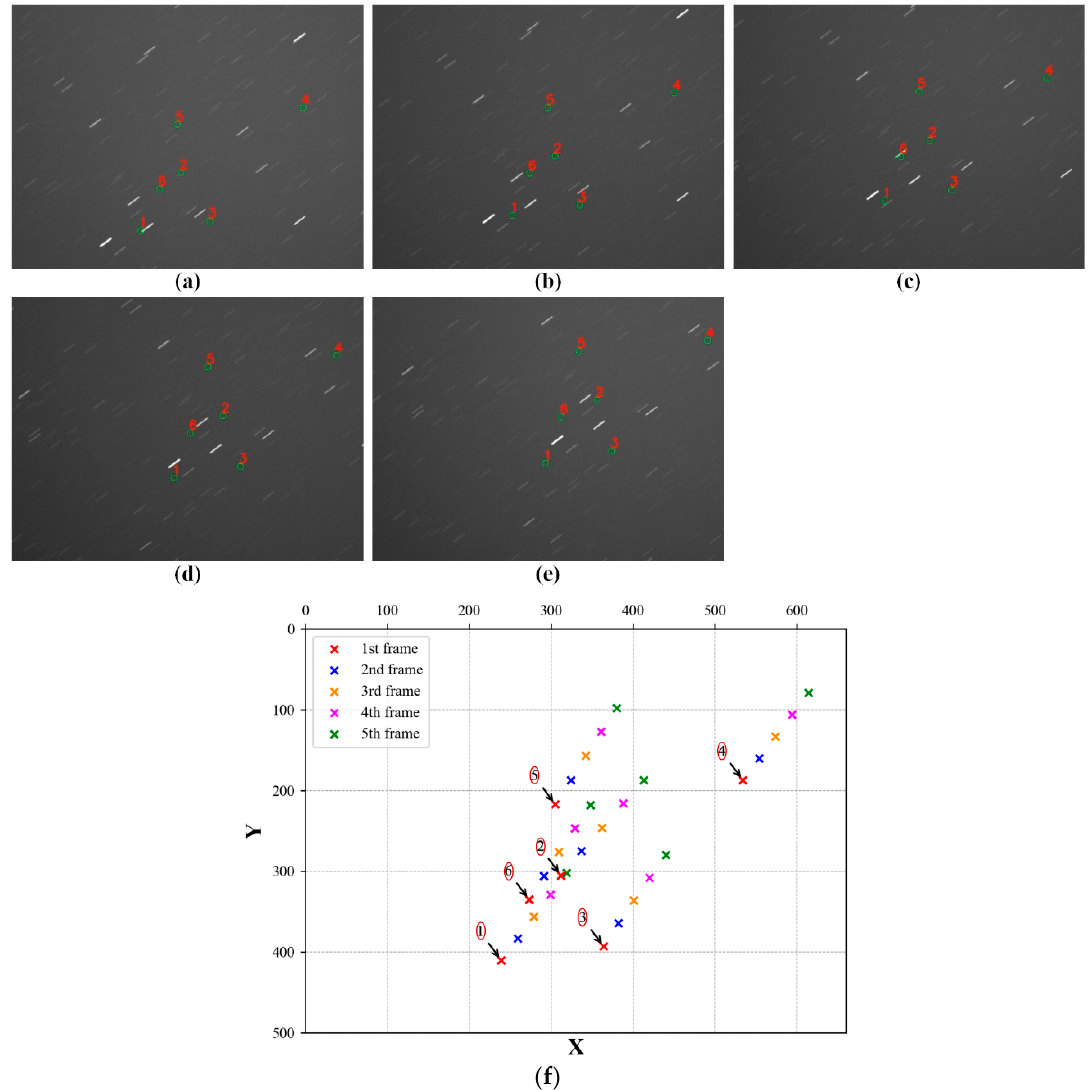
Figure 2. An example image sequence of the SpotGEO dataset. ( a ) The typical sequence that captures three objects. ( b ) Object detection in a sequence of 5 consecutive frames. The source positions are shown by the circle symbols in different colors.